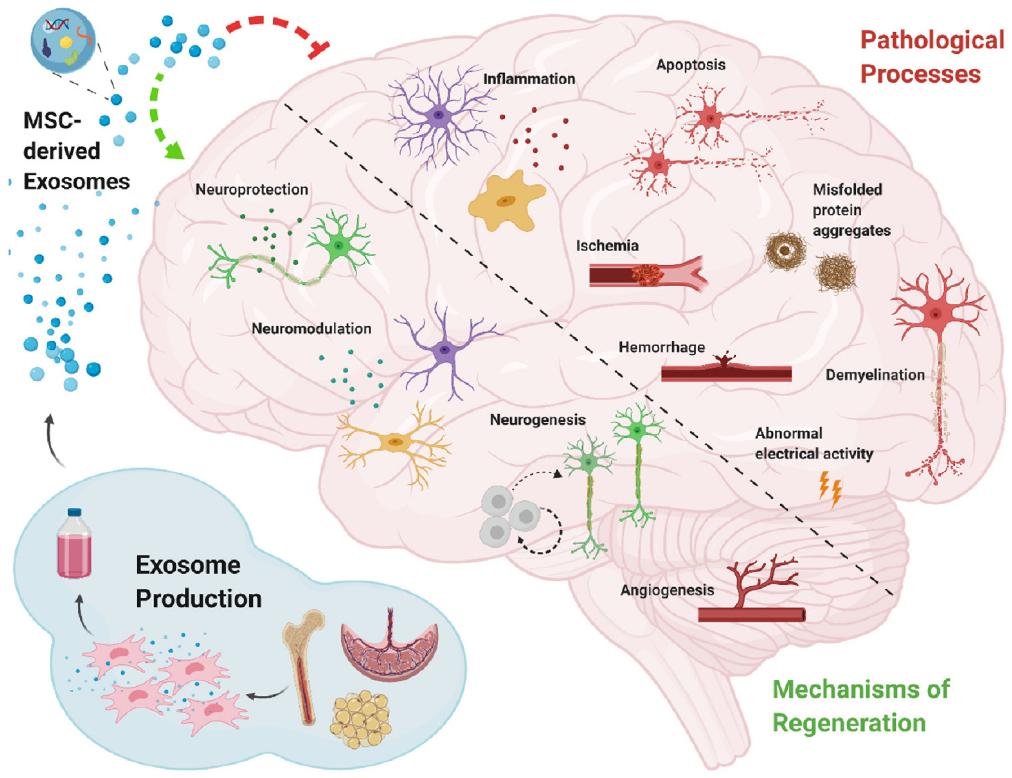
Figure 2. Schematic diagram of key mechanisms of mesenchymal stem cell-derived exosomes for the treatment of neurodegenerative diseases [36]. Table 2. Example of MSCs-Exo against neurodegenerative diseases.